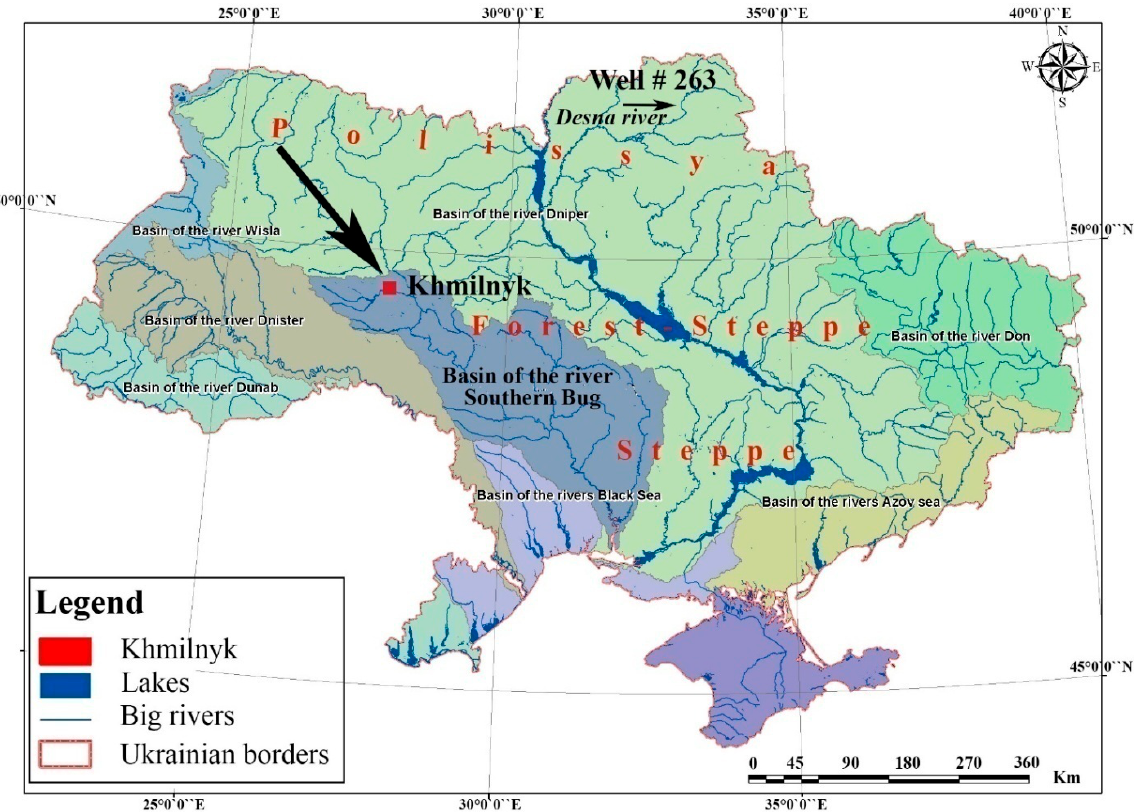
Figure 2. Map of the main river basins within Ukraine. Red square denotes location of experimental hydrogeological control section (wells #5-2, #5-3, #5-5, the river gauge station), a small black arrow indicates the observation well № 263 on the Desna River.